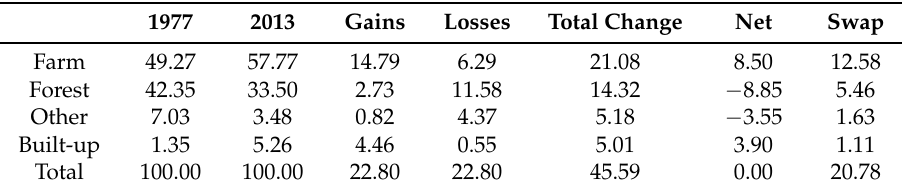
Table 3. Percentages of gains, losses, net changes, and swaps of different land uses.